Question: How would you classify this visualization?
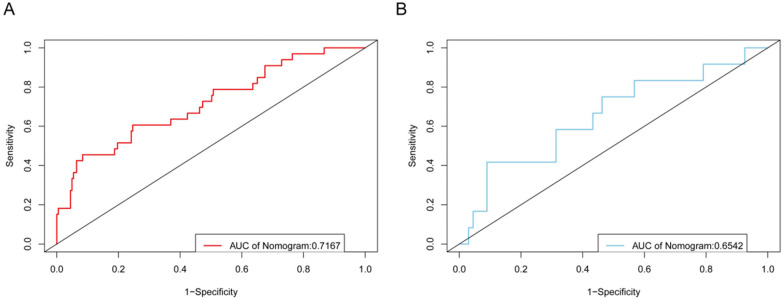
Answer: line